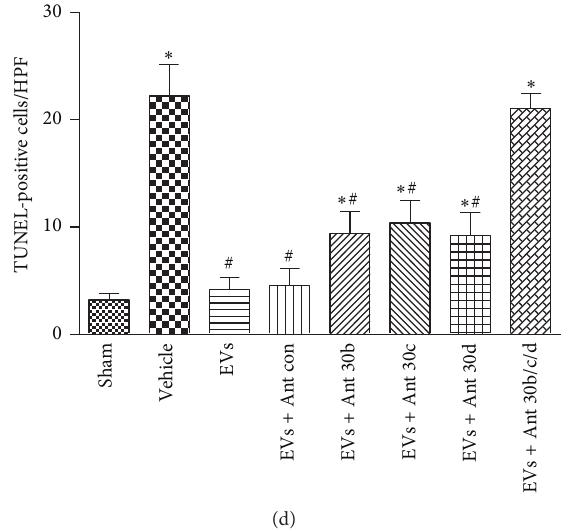
Figure 4: Mitochondrial apoptotic pathways are inhibited by EVs-derived miR-30. Immunochemistry staining for caspase 9 and TUNEL assay were carried out in kidney tissue. (a) Representative micrographs illustrating caspase 9 expression in kidney tissues. In comparison with EVs group, the vehicle group and antagomir-treated group exhibited stronger positive staining for caspase 9 in kidney tissue sections (the original magnification is 400x). (b) Quantification of caspase 9-positive tubular epithelial cells in the kidney sections. (c) Representative images of TUNEL staining in kidney tissues (magnification 400x). (d) Quantification of TUNEL-positive tubular epithelial cells in the kidney sections. Data in (b) and (d) are presented as mean ± SD; 𝑛 = 6 ; ∗ 𝑃 < 0.05 , versus sham; # 𝑃 < 0.05 , versus vehicle.